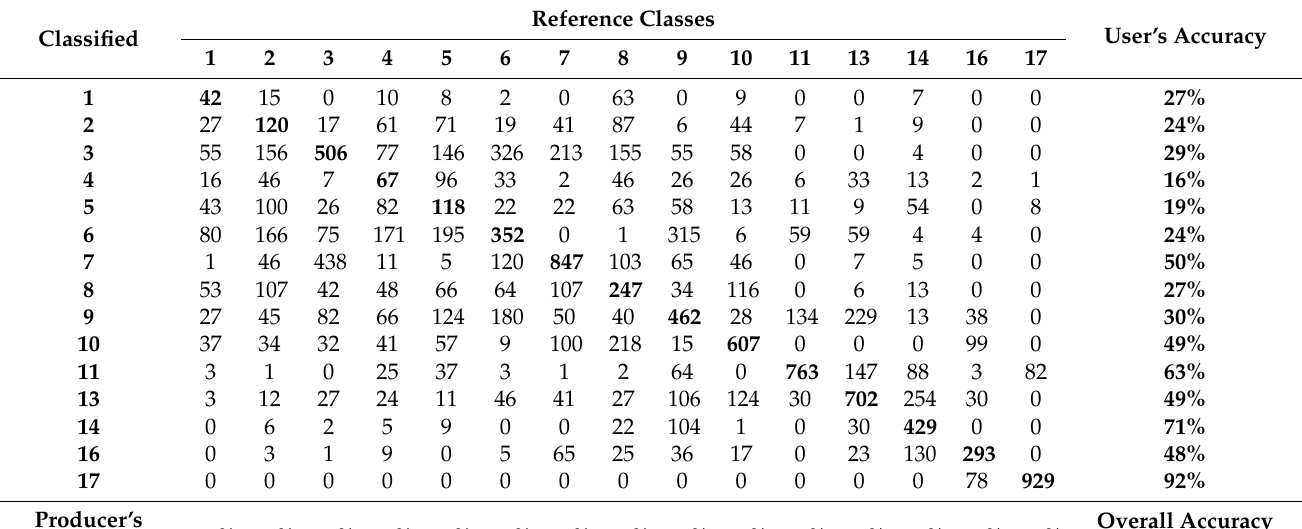
Table 3. Confusion matrix from the standard LCZ training single date spring image over Cape Town.